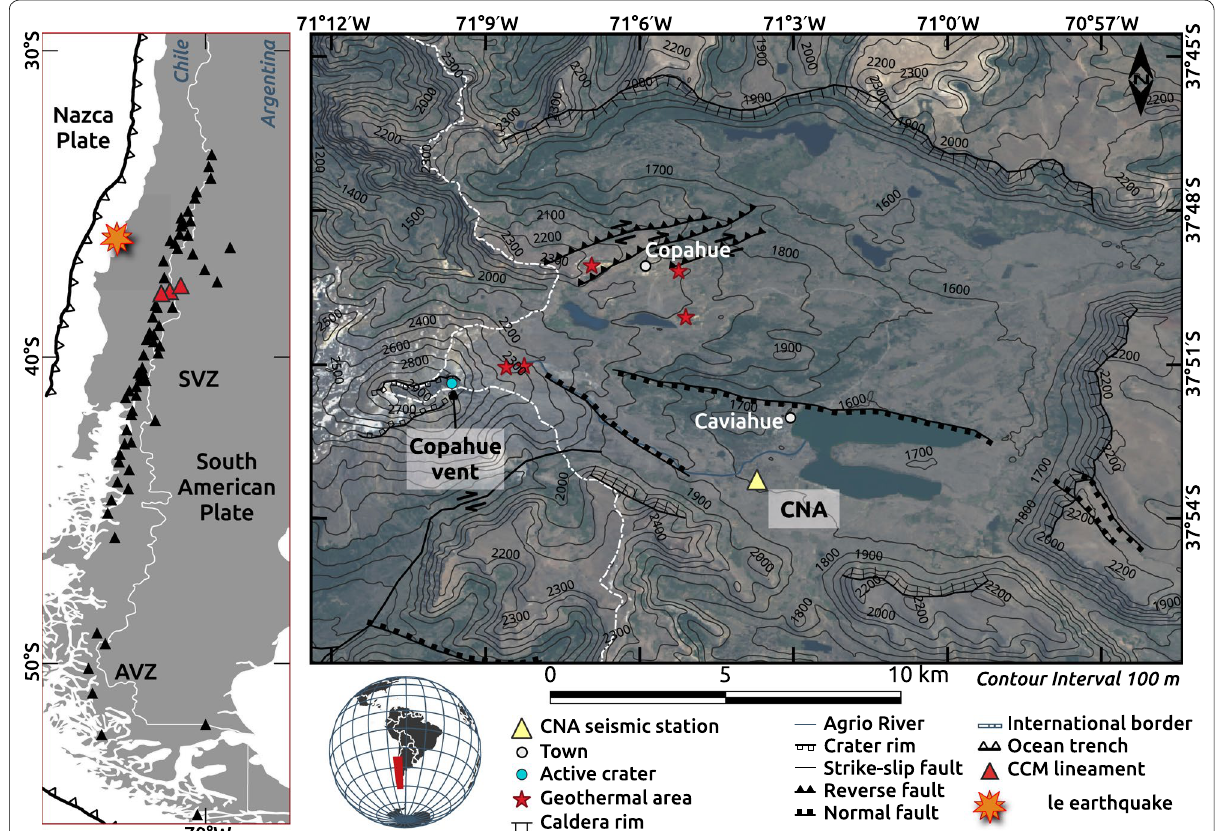
Fig. 1 Geotectonic setting for Copahue Volcano. (left) Geotectonic setting of Southern Volcanic Zone (SVZ) and Austral Volcanic Zone (AVZ), showing the Callaqui–Copahue–Mandolegüe (CCM) N60 ◦ E-striking lineament and the epicenter of the M w 8.8 Maule earthquake. (Right) Map of Caldera del Agrio and Copahue volcano with the tectonic framework, the location of the seismic station (CNA), the active crater, and the main geothermal areas. Main fault systems and lineaments were mapped based on Melnick et al.